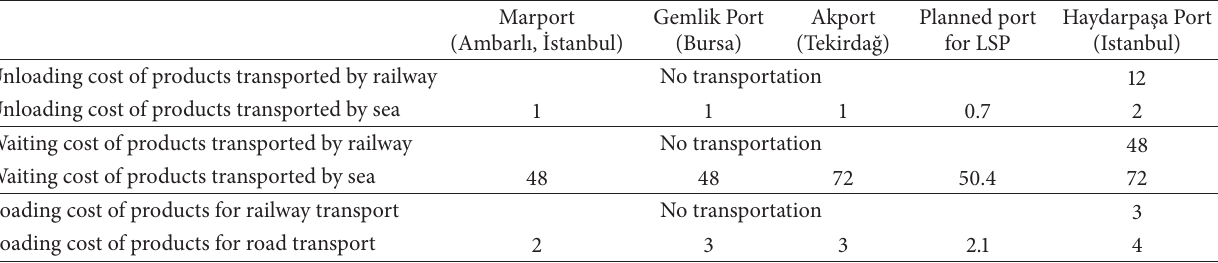
Table 13: Unloading, warehousing, and loading times in the second transshipment terminals